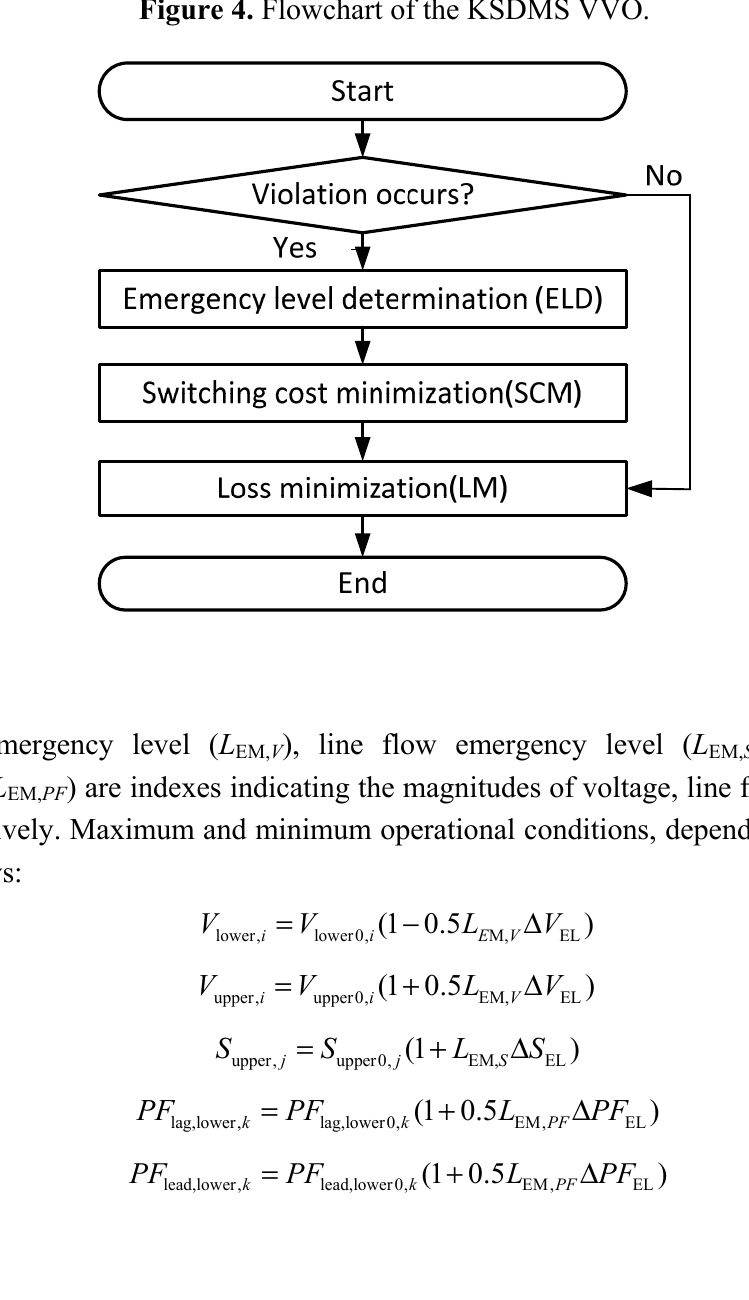
Figure 4. Flowchart of the KSDMS